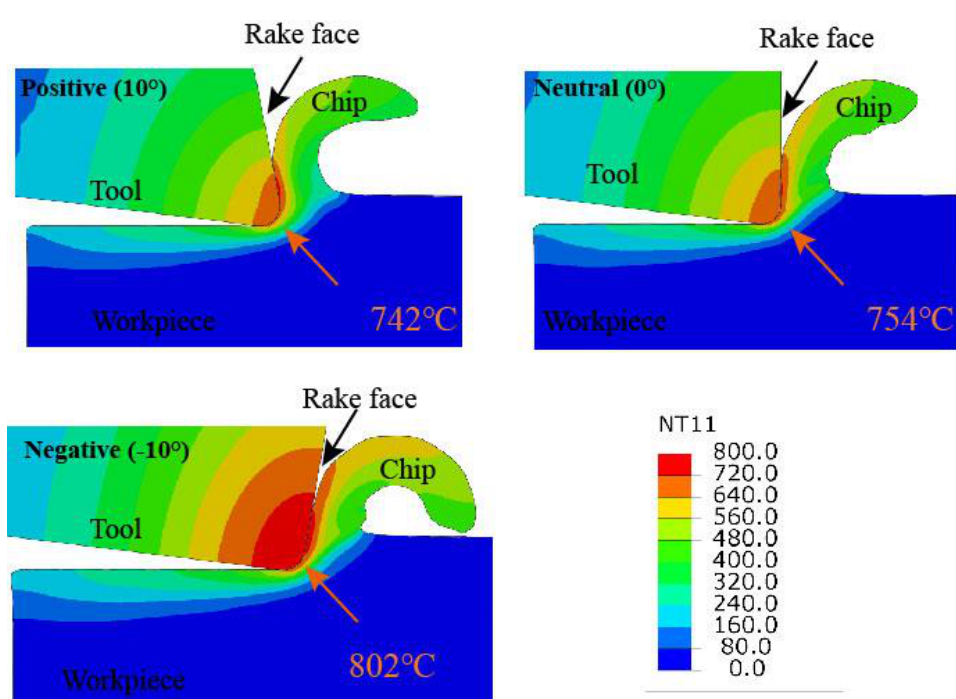
Figure 9. The simulated thermal map distribution in the orthogonal cutting of Inconel 718 with different rake angle tools.